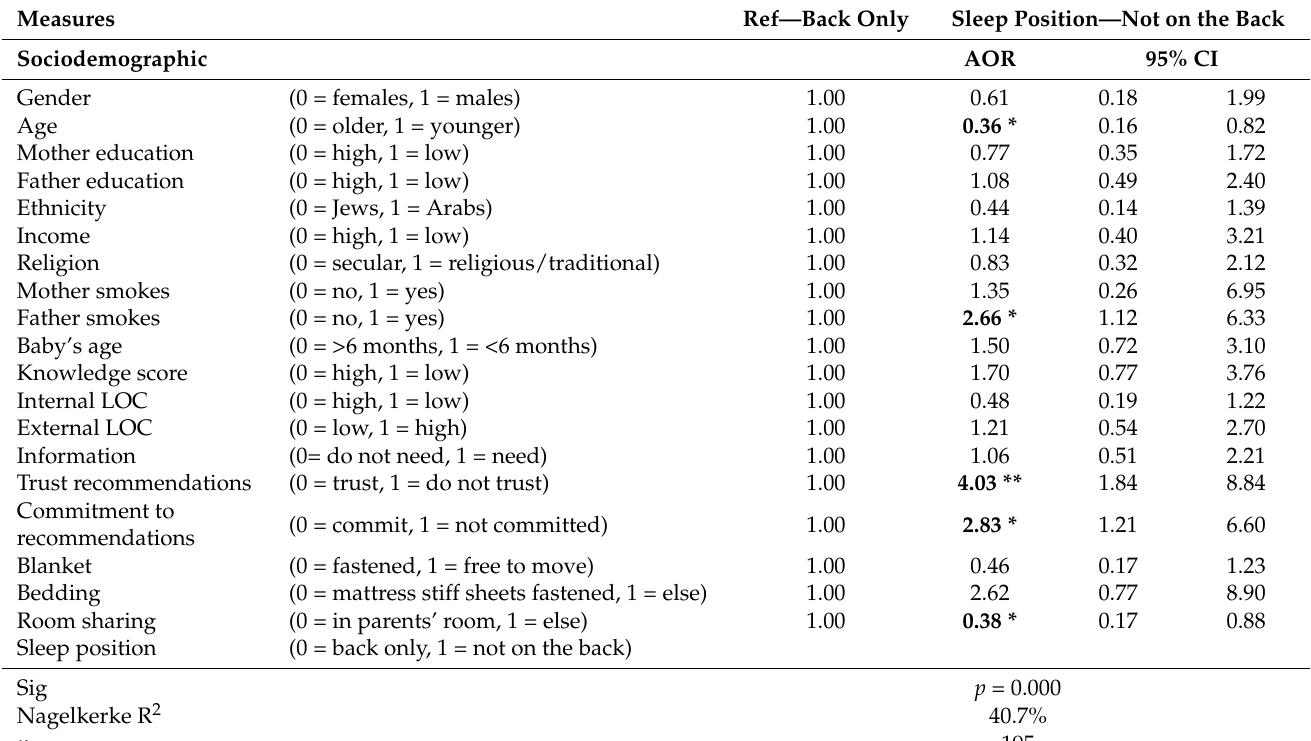
Table 5. Outcomes of logistic regression—adjusted odds ratios (AORs) for associations between baby sleep position and other study